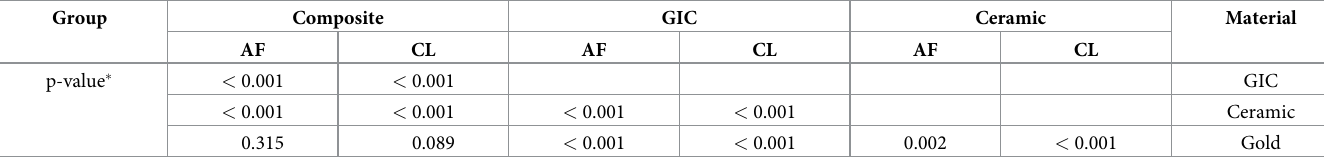
Table 7. Intragroup comparison of p-values between the median Rq of used restoration materials � .